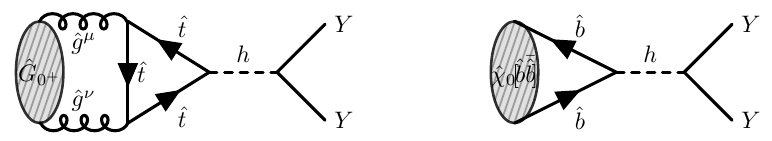
and twin bottomonium ^ (cid:31) 0 decays to the SM 0 +